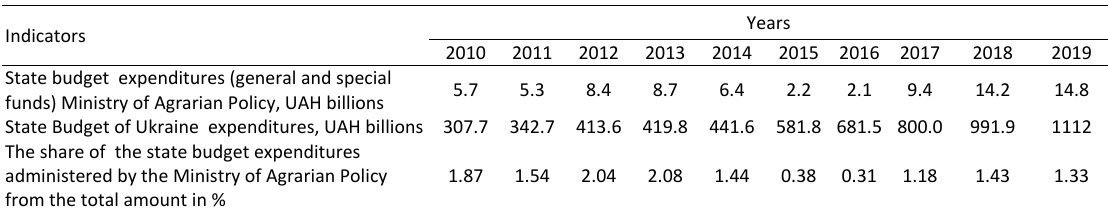
Table 2: The share of state budget expenditures on financing agriculture in Ukraine for 2010-2019 (Legislation of Ukraine, 2019; On the state budget of Ukraine; Ministry of agrarian policy and food of Ukraine, 2019) Indicators